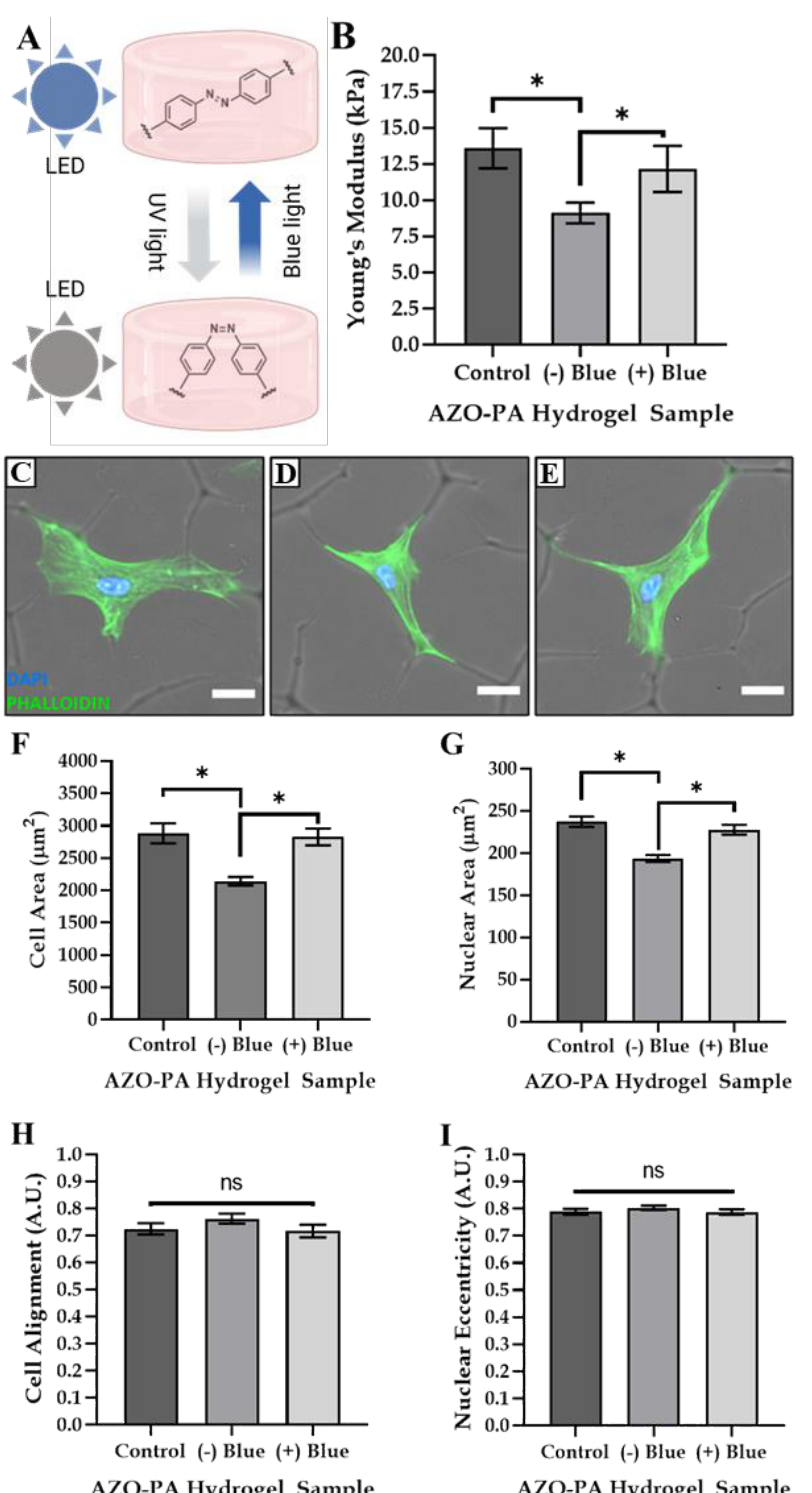
Figure 6. Photoswitchable matrix stiffness influenced cell size but not cell shape. ( A ) A schematic, created with BioRender.com, demonstrating the mechanical tuning of AZO-PA hydrogels with light; ( B ) the influence of photo-crosslinking method on the Young’s modulus of AZO-PA hydrogels; DAPI/phalloidin staining of MSCs cultured on ( C ) control, ( D ) ( − ) blue and ( E ) (+) blue hydrogel samples (scale bar = 25 µ m) and the effect of matrix stiffness on ( F ) cell area, ( G ) nuclear area, ( H ) cell alignment and ( I ) nuclear eccentricity. * indicates p < 0.05, ns indicates no significant differences.